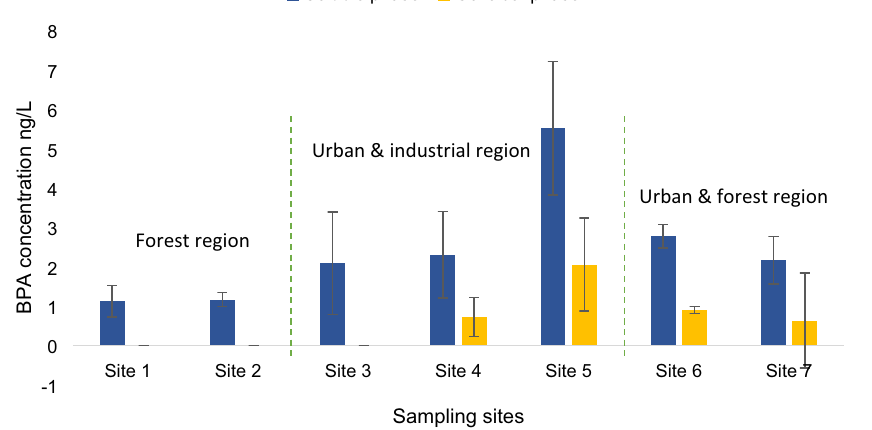
Figure 4. Distribution of BPA in the soluble and colloidal phases in Bentong